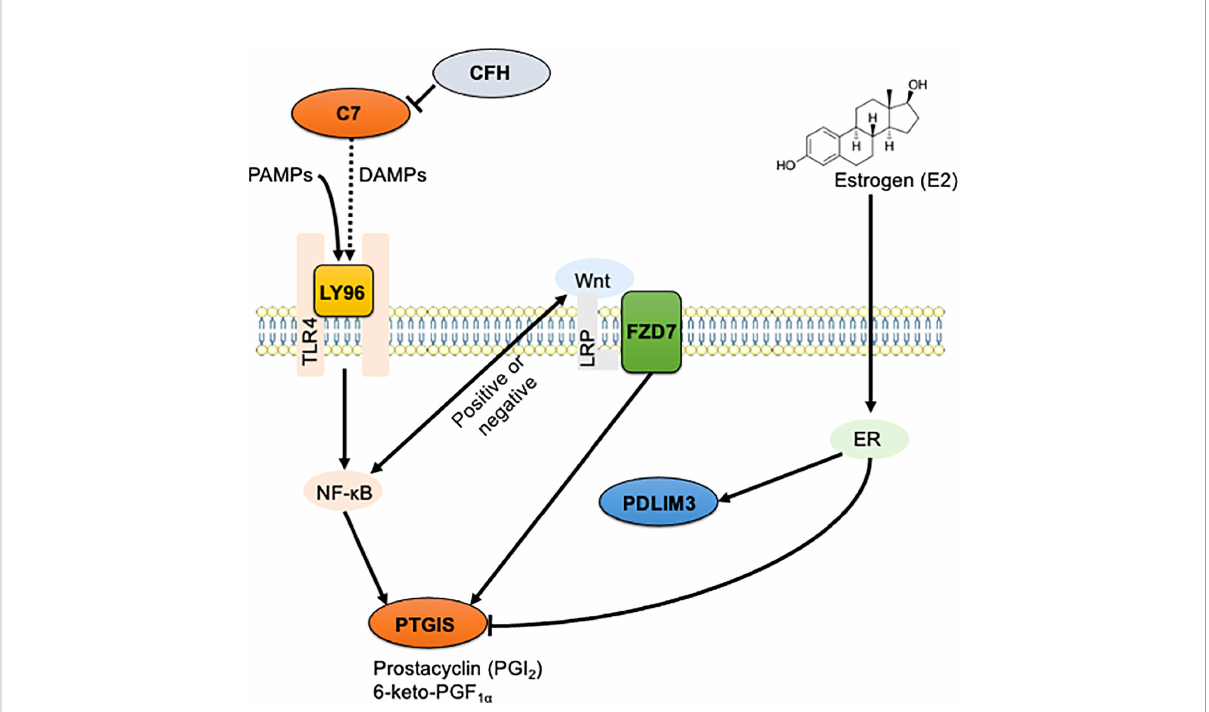
FIGURE 6 The schematic illustration of the hypothesized signaling network in endometriosis. Signaling interaction between six identi fi ed DEGs including C7 , CFH , FZD7 , LY96 , PDLIM3 , and PTGIS , and three enriched pathways including TLR4/NF- k B, Wnt/frizzled, and estrogen receptors were hypothesized and schematically illustrated. Solid line indicates direct interaction, and dashed line indicates indirect and/or proposed